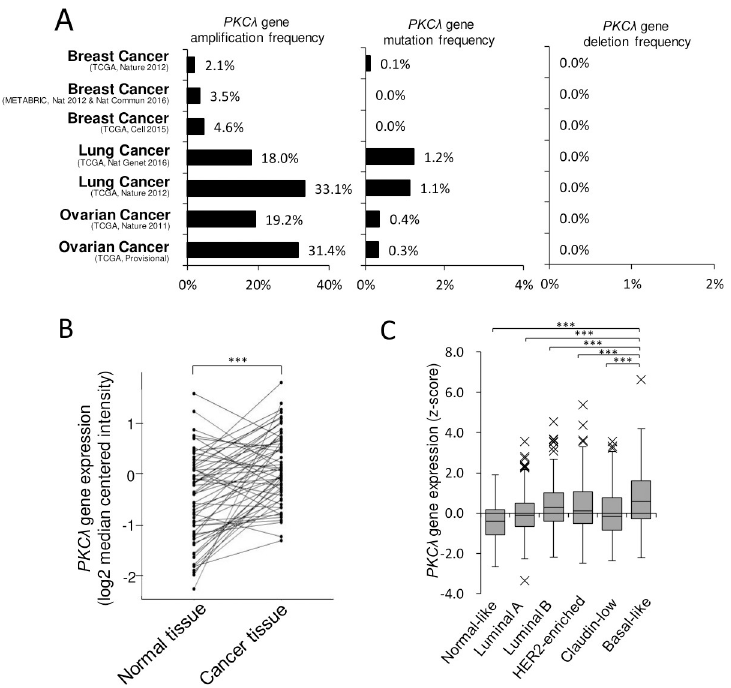
Fig 1. PKC λ mRNA overexpression with a low frequency of gene alterations in breast cancer. (A) PKC λ gene alterations (amplification, mutation and deep deletion frequency) in breast, lung, and ovarian cancers. (B) Paired comparison of PKC λ expression in normal and tumor tissues from TCGA dataset analysis of normal vs cancer tissue, n = 60. The p values were calculated using the Wilcoxon signed rank test. (C) PKC λ mRNA expression in breast cancer PAM50 subtypes from the METABRIC dataset. n = 1898. Centerline, median; box limits, lower (Q1) and upper (Q3) quartile, whiskers, ± 1.5 x interquartile range (IQR); x, outlier. ��� p < 0.001; Kruskal-Wallis test with Steel-Dwass test.